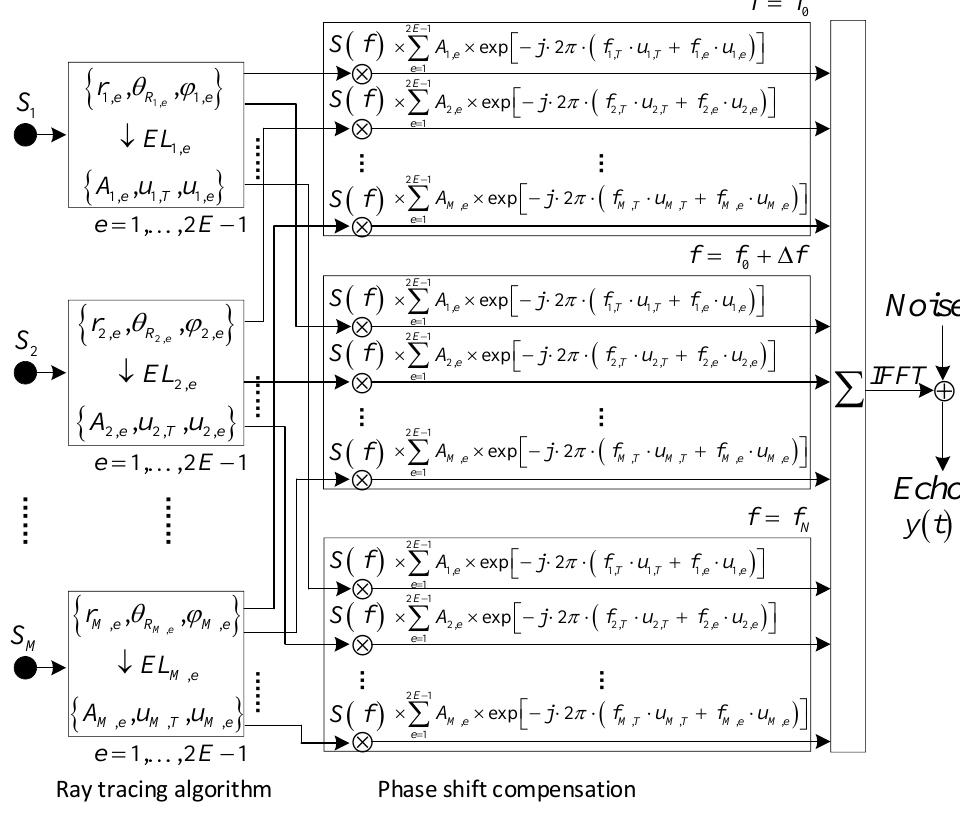
Figure 9. Echo signal fitting